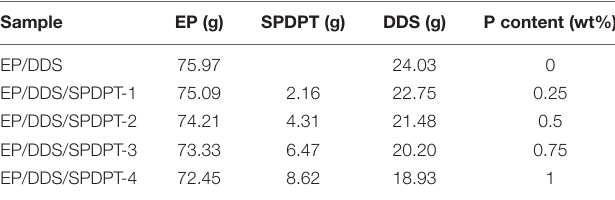
TABLE 1 | The detailed formulations of EP